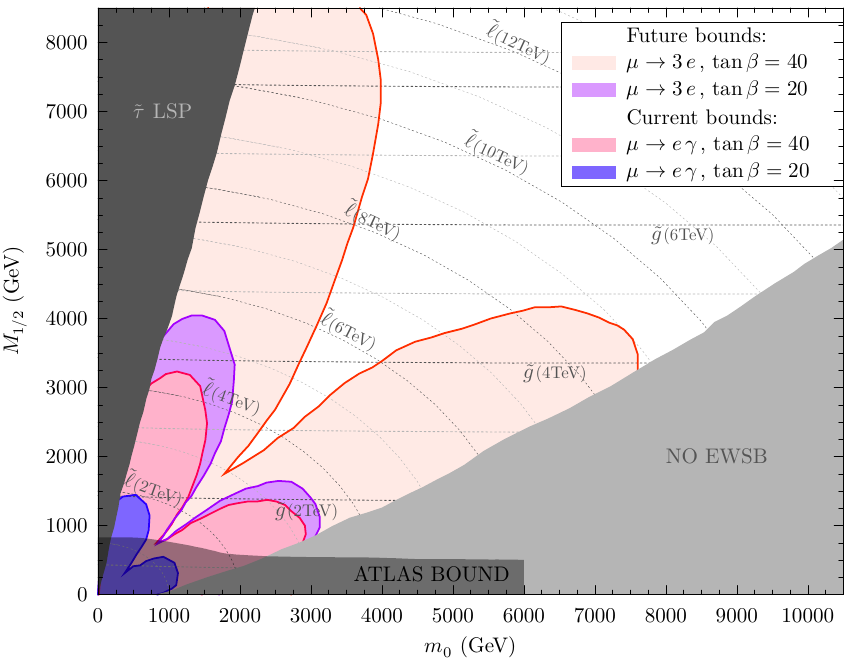
Figure 1 . Excluded regions due to (cid:22) ! e(cid:13) and (cid:22) ! eee for two reference values: tan (cid:12) = 20 (blue shapes) and tan (cid:12) = 40 (red shapes). In the dark (blue and red) regions, we compare with current (cid:22) ! e(cid:13) bounds, while in the light (blue and red) regions we compare with the expected (cid:22) ! eee sensitivity in the near future. Interestingly, even for present bounds, these results are competitive with mSUGRA ATLAS limits (gray